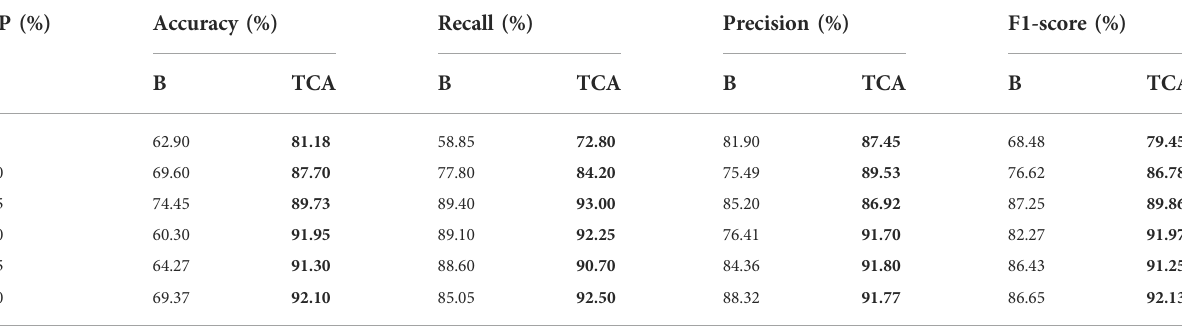
TABLE 4 Performance values in terms of accuracy, recall, precision and F1-score for Baseline (B) and Transfer Component Analysis (TCA). SP (%)